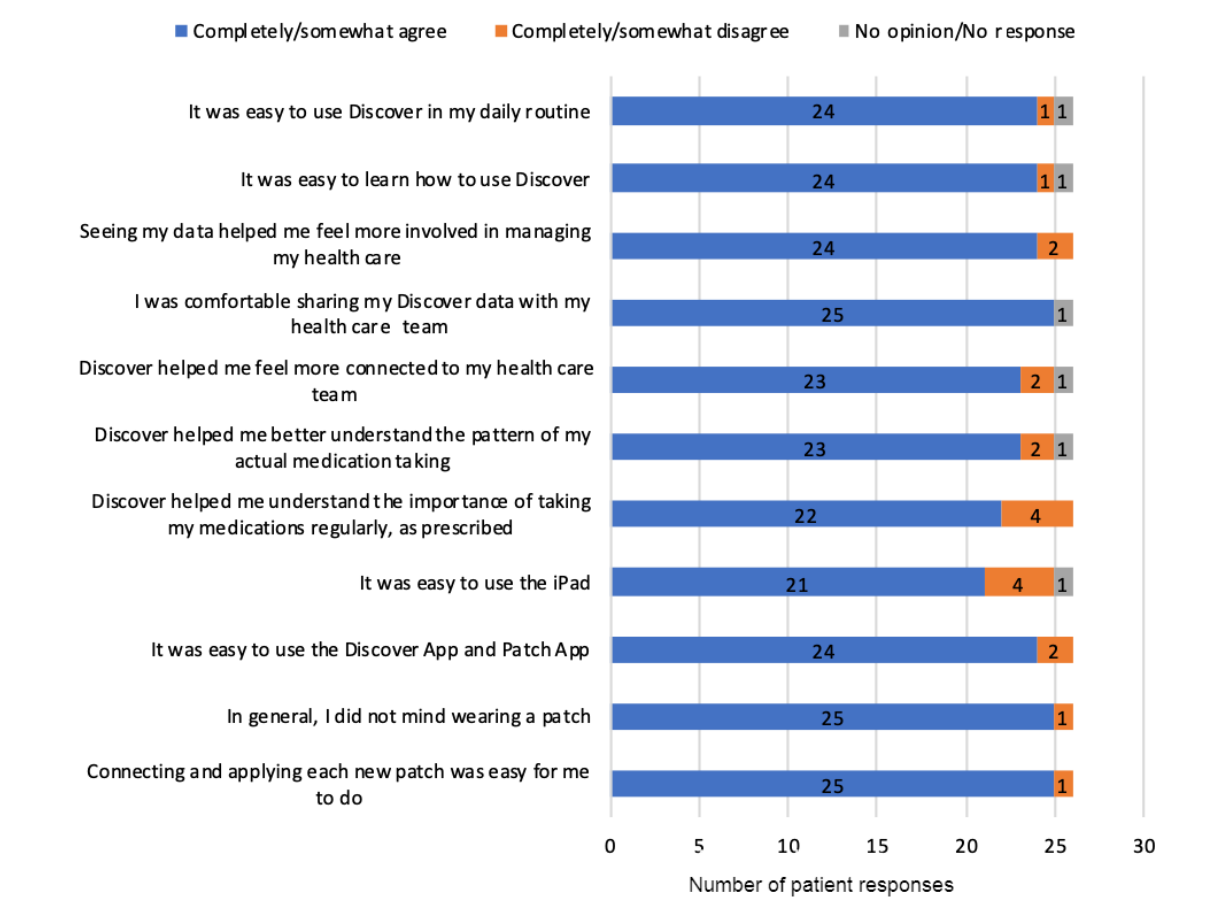
Figure 1. Patient satisfaction survey results